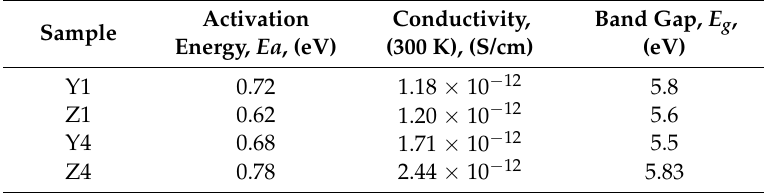
Table 2. Electrical properties for the PVA/ZnO composites